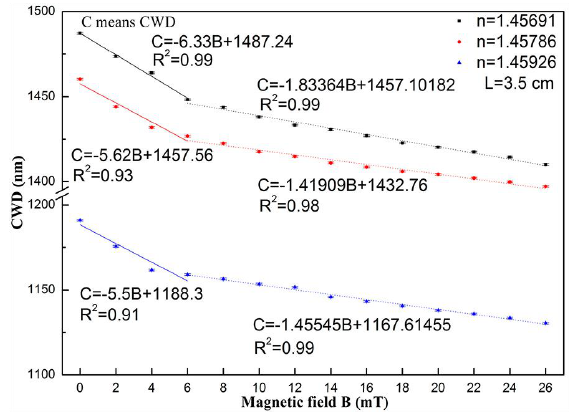
Figure 28. Dependence of the CWD with the magnetic field, for sensing structures covered with MF with distinct refractive indices [83].